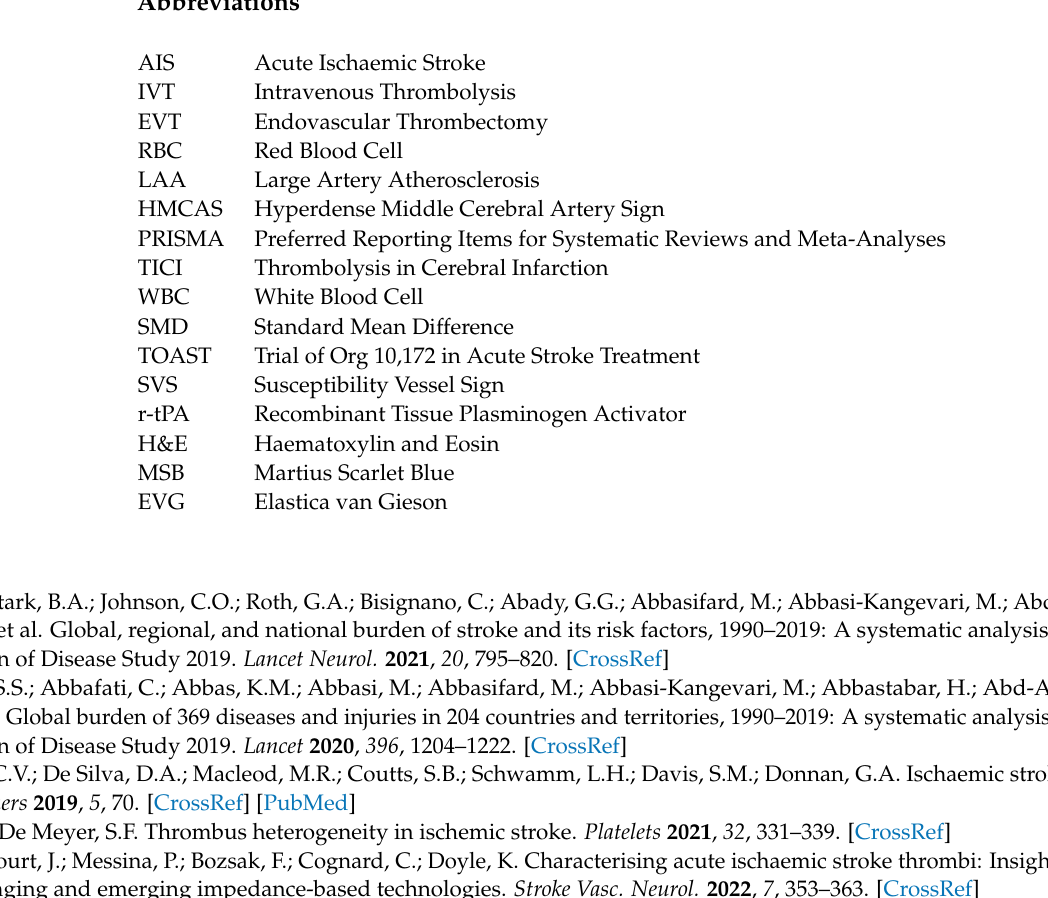
Bridging Thrombolysis; Table S1: Modified Jadad Analysis for Methodological Quality; Table S2: Baseline characteristics of studies excluded from meta-analysis; Table S3: Egger’s test for publication bias assessment of the included studies; Table S4: Summary Effects of